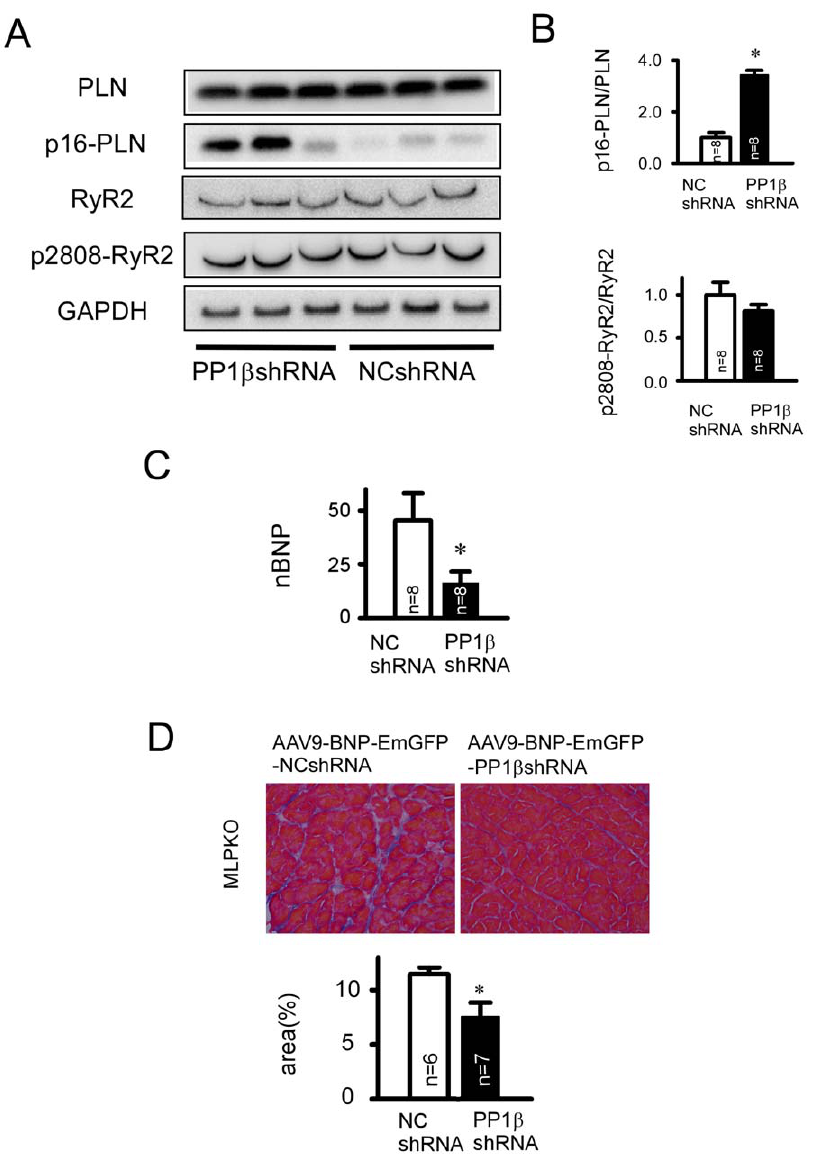
Figure 6. AAV9-mediated heart-failure-inducible PP1 b shRNA increased PLN phosphorylation at Ser16, reduced BNP expression, and ameliorated cardiac interstitial fibrosis. A : Immunoblots of the key SR phosphoproteins and analysis of the phosphorylation levels by using phosphospecific antibodies in LV homogenates at 3 months after gene transfer. B : Summaries of the phospholylation levels of PLN at Ser16 and RyR at Ser2808. ‘‘*’’ indicates p , 0.05 vs. the NCshRNA treated group. (n=8 in PP1 b shRNA treated group and n=8 in NCshRNA treated group). C : Expression analysis of normalized BNP (nBNP) using real-time RT-PCR from the AAV9 shRNA transfected heart tissue. ‘‘*’’ indicates p , 0.05 vs. the NCshRNA treated group. (n=8 in the NCshRNA treated group, n=8 in the PP1 b shRNA treated group). D : Representative images of Heidenhain’s trichrome staining in the AAV9-BNP-EmGFP-NCshRNA- andAAV9-BNP-EmGFP-PP1 b shRNA treated hearts at 3 months after gene transfer. The lower graph shows the quantitative image analysis of percentage of the area of interstitial fibrosis. ‘‘*’’ indicates p , 0.05 vs. the NCshRNA treated group. (n=6 in NCshRNA treated group and n=7 in PP1 b shRNA treated group).